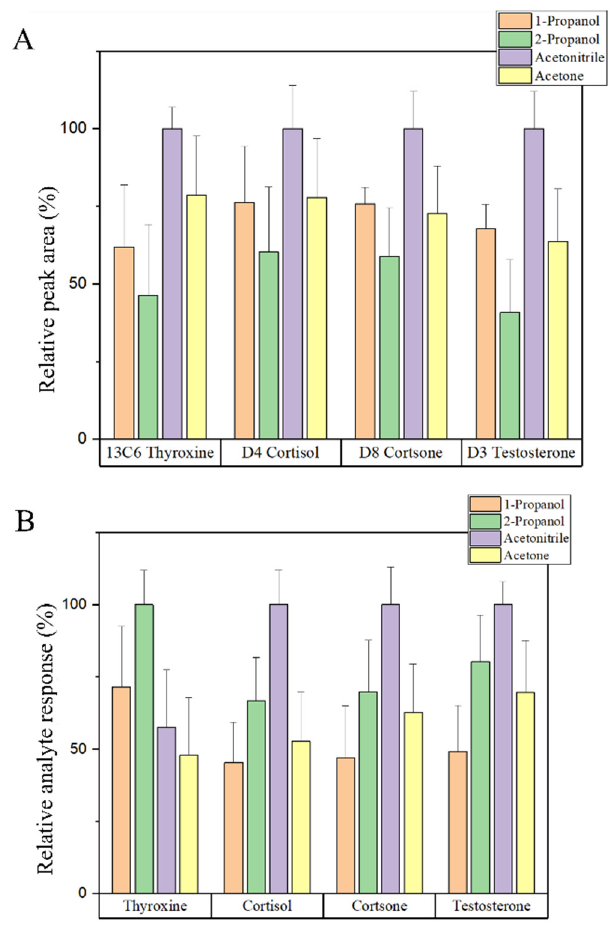
Figure 1. Results from post-extraction spiking experiments revealing the effect of using different solvents. Relative internal standard peak areas ( A ) show the relative degrees of matrix effects causing ion suppression noticed by peak area reduction. Relative analyte response ( B ) is the relative peak area ratio (analyte/internal standard) and is directly proportional to relative extraction recovery. Data are reported as mean + standard deviation, n = 3.